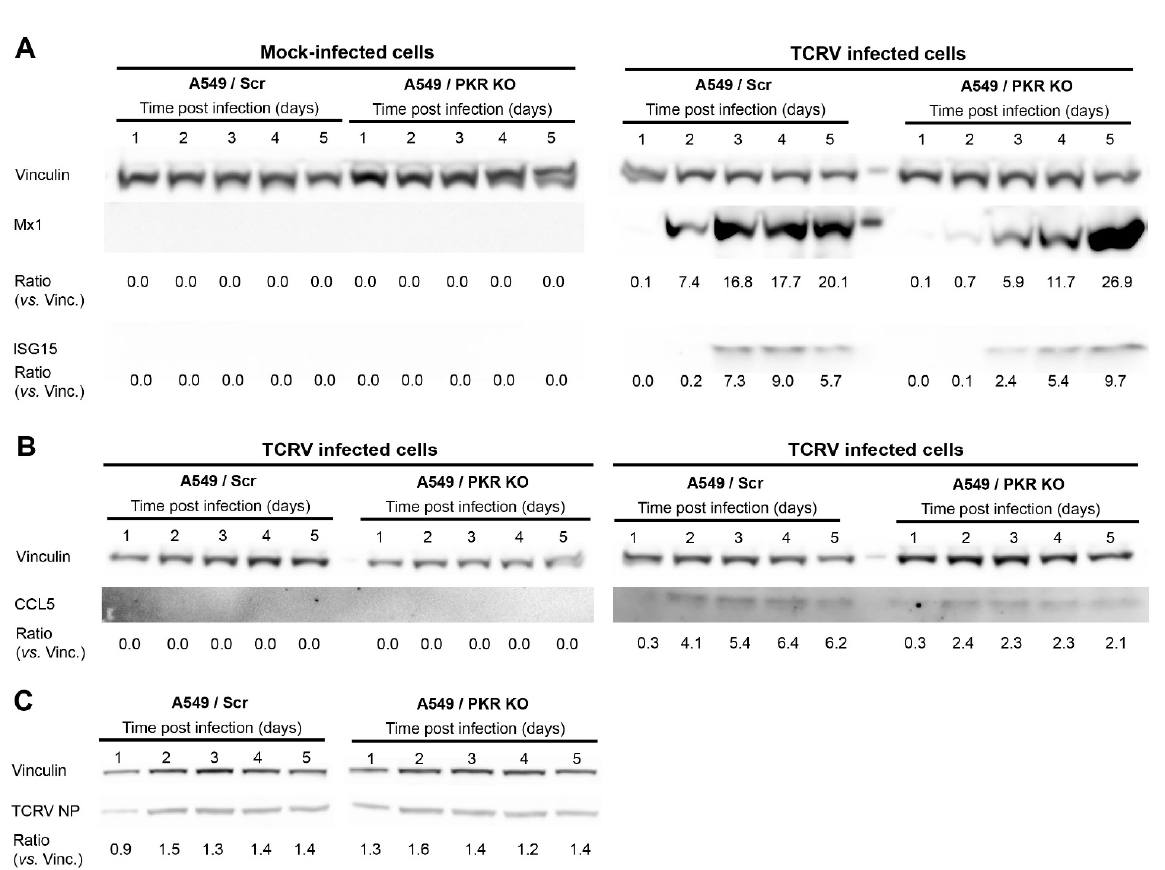
Figure 2. Protein expression of Mx1, ISG15, and CCL5 in TCRV-infected A549/Scr and A549/PKR cells. Cells were infected with TCRV at MOI of 0.01 PFU/cell and cell lysates were collected every 24 h. Total cellular proteins were probed for Mx1, ISG15 ( A ), and CCL5 ( B ), expression by Western blotting. Vinculin was included as a loading control. The ratios of Mx1, ISG15, and CCL5 versus Vinculin were calculated by densitometry at the corresponding day postinfection. One representative example out of three independent experiments is shown; ( C ) TCRV NP expression in A549/Scr and A549/PKR KO cells.